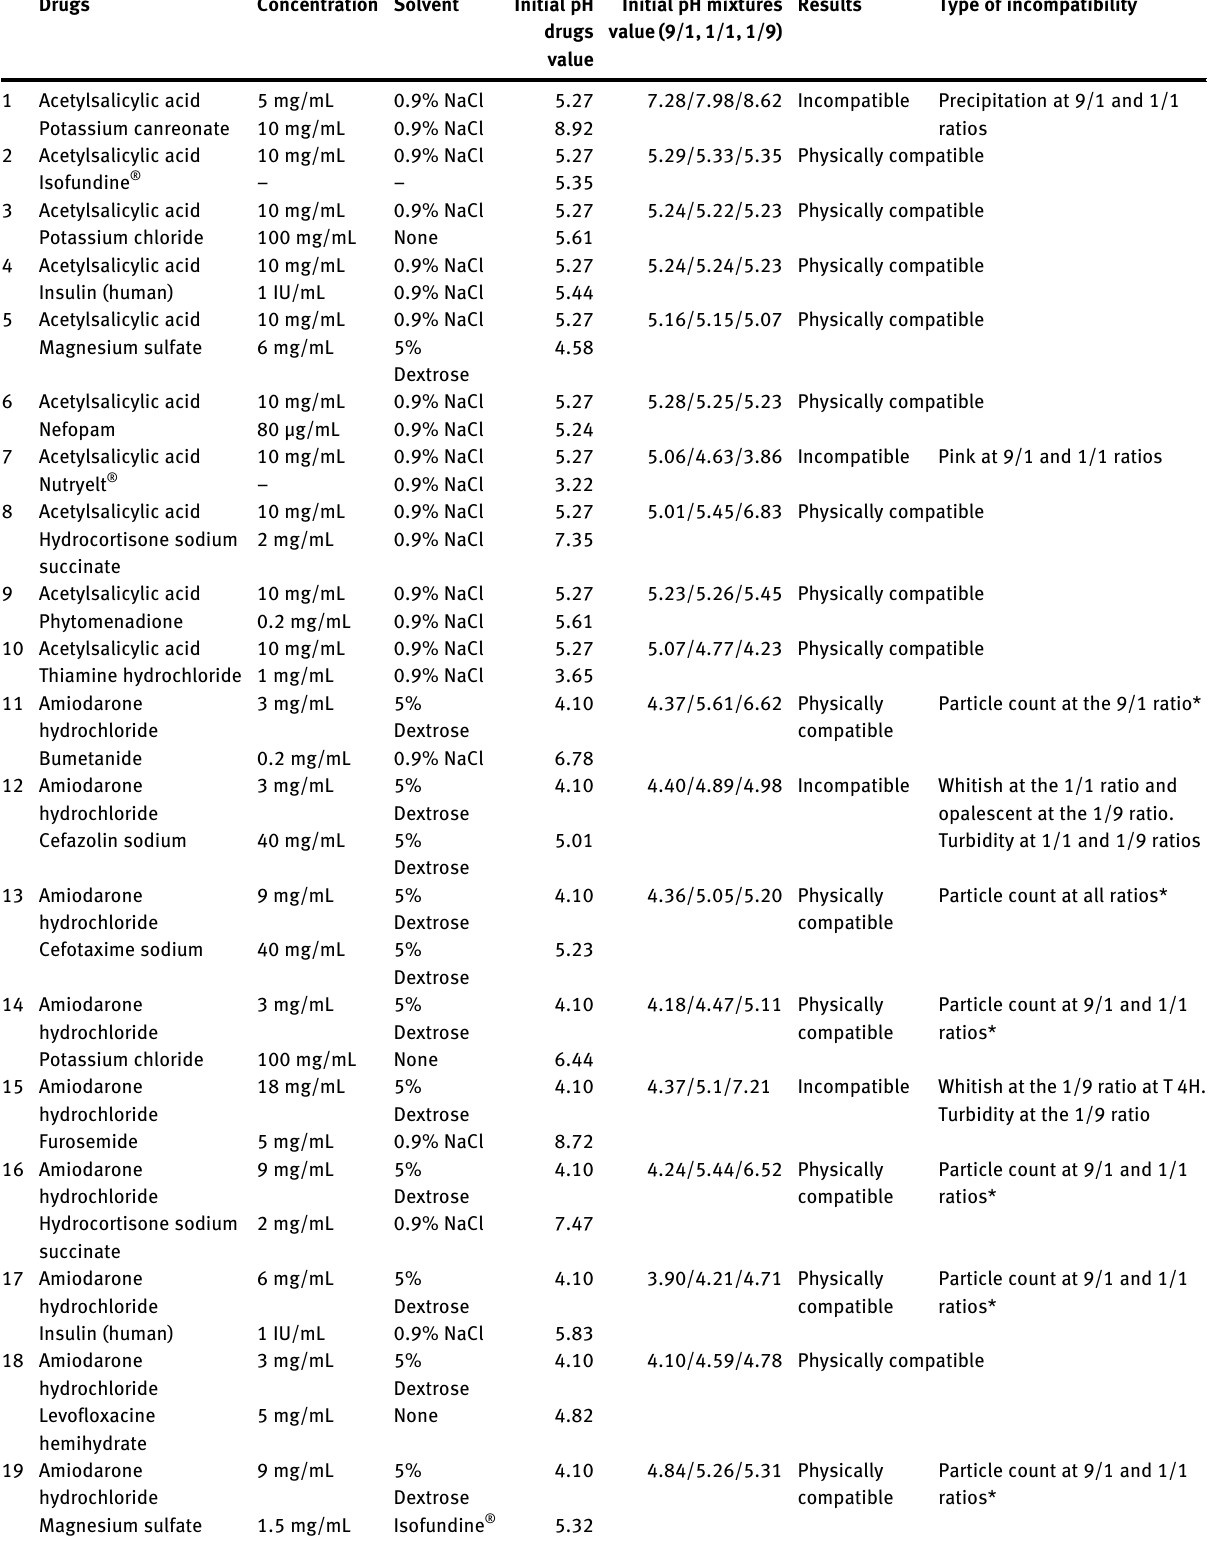
Table  : Mixtures of drugs performed in this study and results of